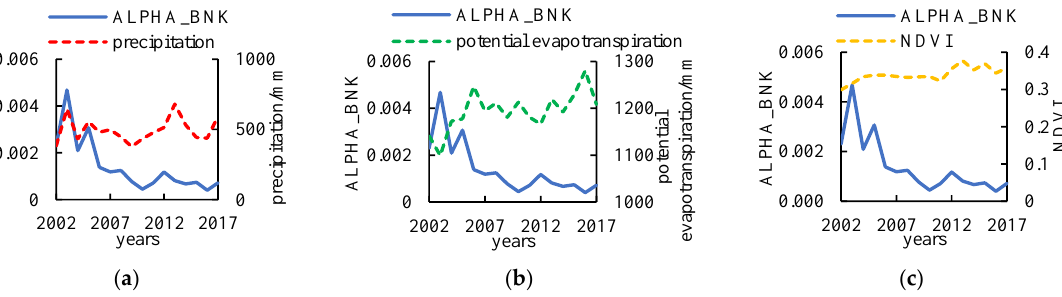
Figure 10. Time-varying process of ALPHA_BNK to basin precipitation, potential evapotranspiration and NDVI. ( a ) Precipitation, ( b ) potential evapotranspiration, ( c ) NDVI.